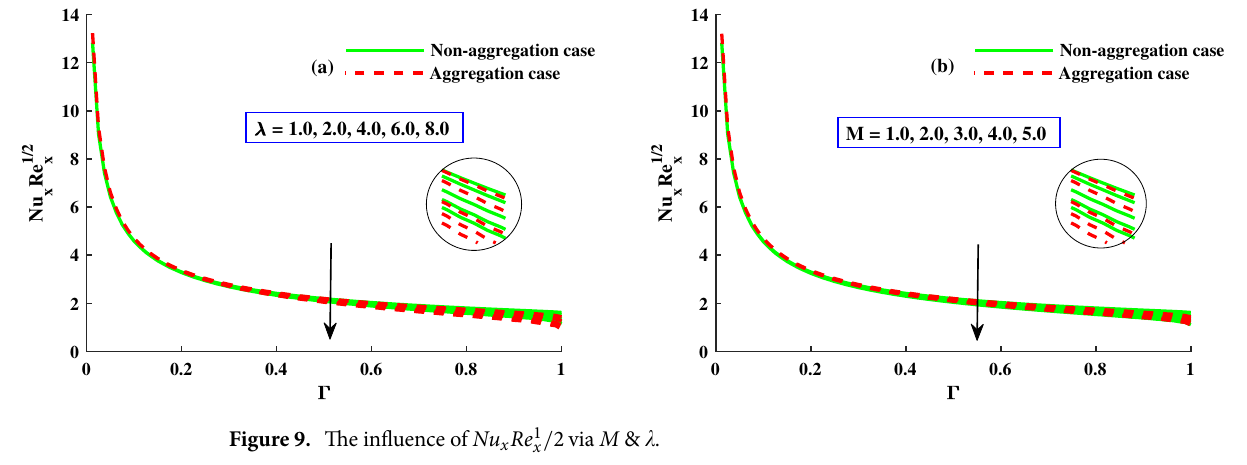
Figure 9. The influence of Nu x Re 1 x / 2 via M & (cid:31)